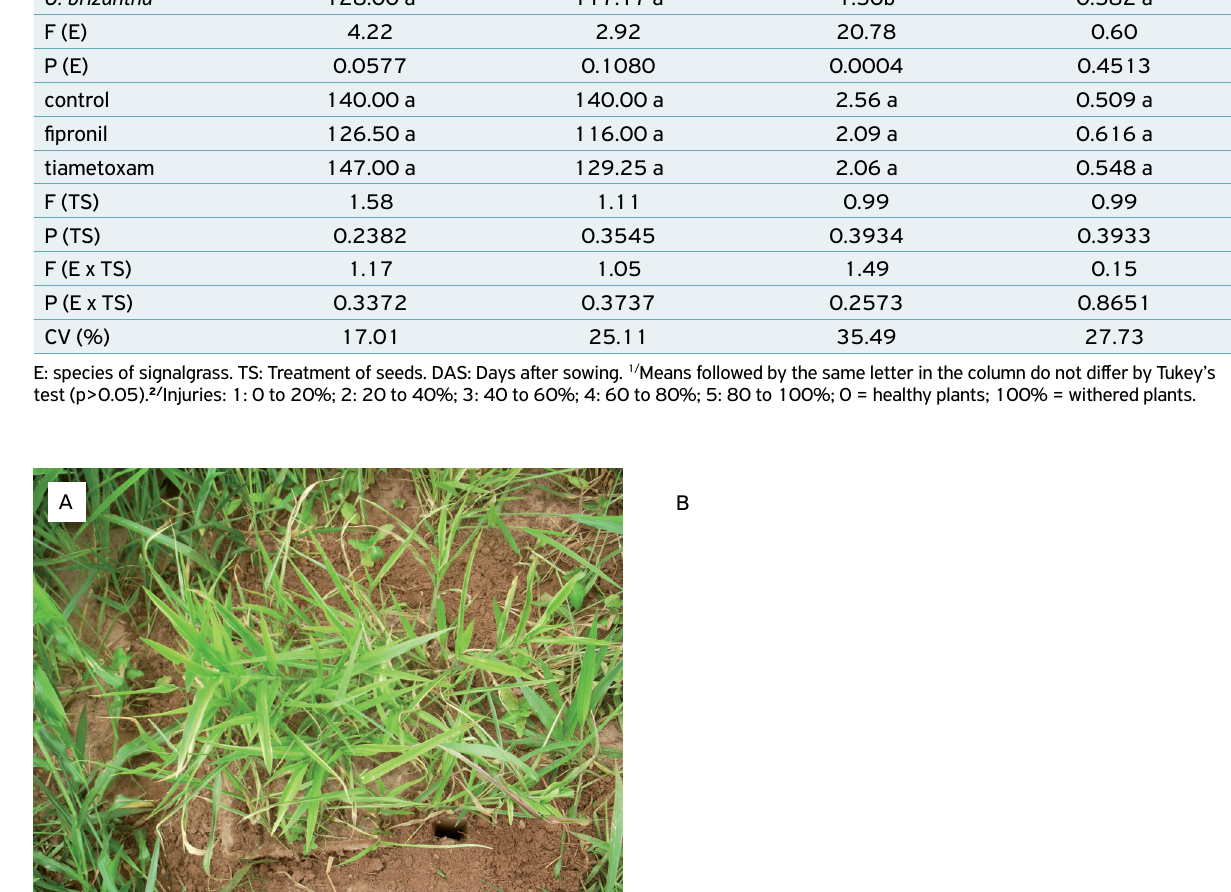
Figure 2. Injuries caused by D . flavopicta adults in U . decumbens (a) and U . brizantha